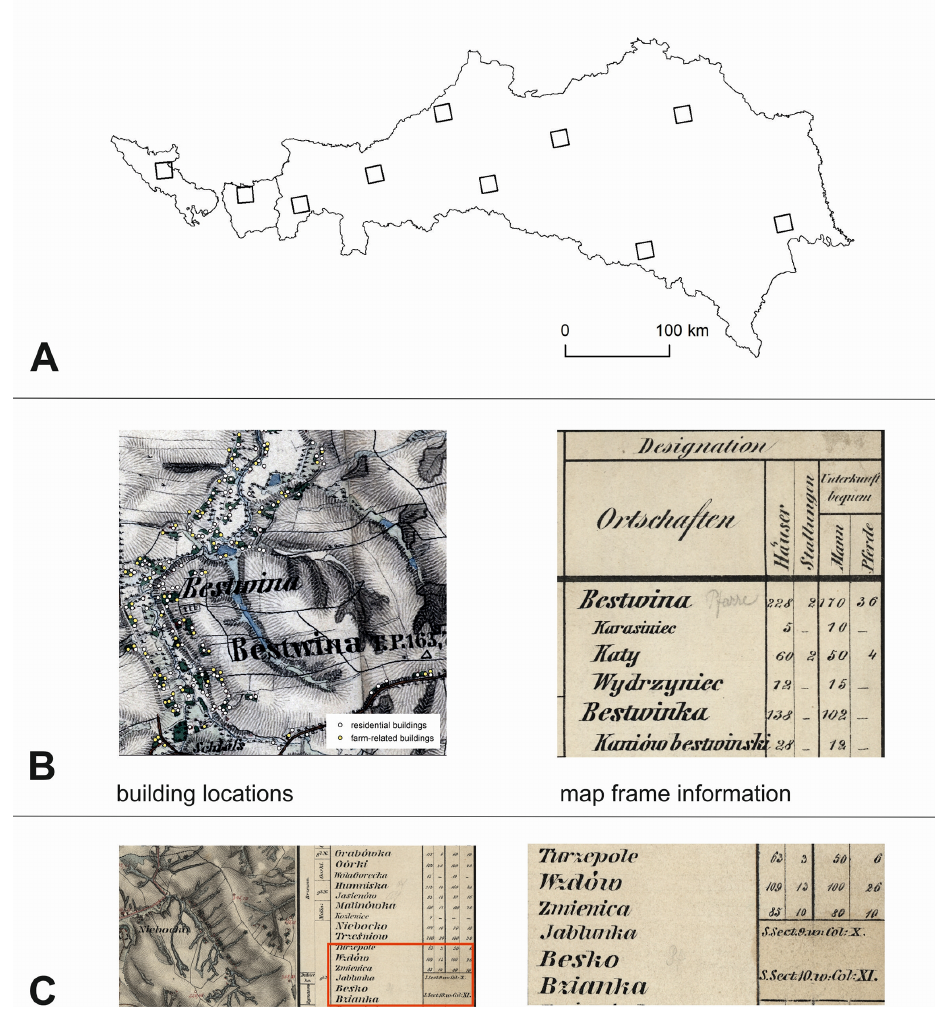
Figure 7. Verification of the building structure numbers acquired from the maps with map frame information. Location of 10 evenly dis- tributed map sheets (a) ; building locations and map frame information (b) ; and information noting that the statistics for the selected villages are available on the neighbouring map sheet (c) (source: Austrian State